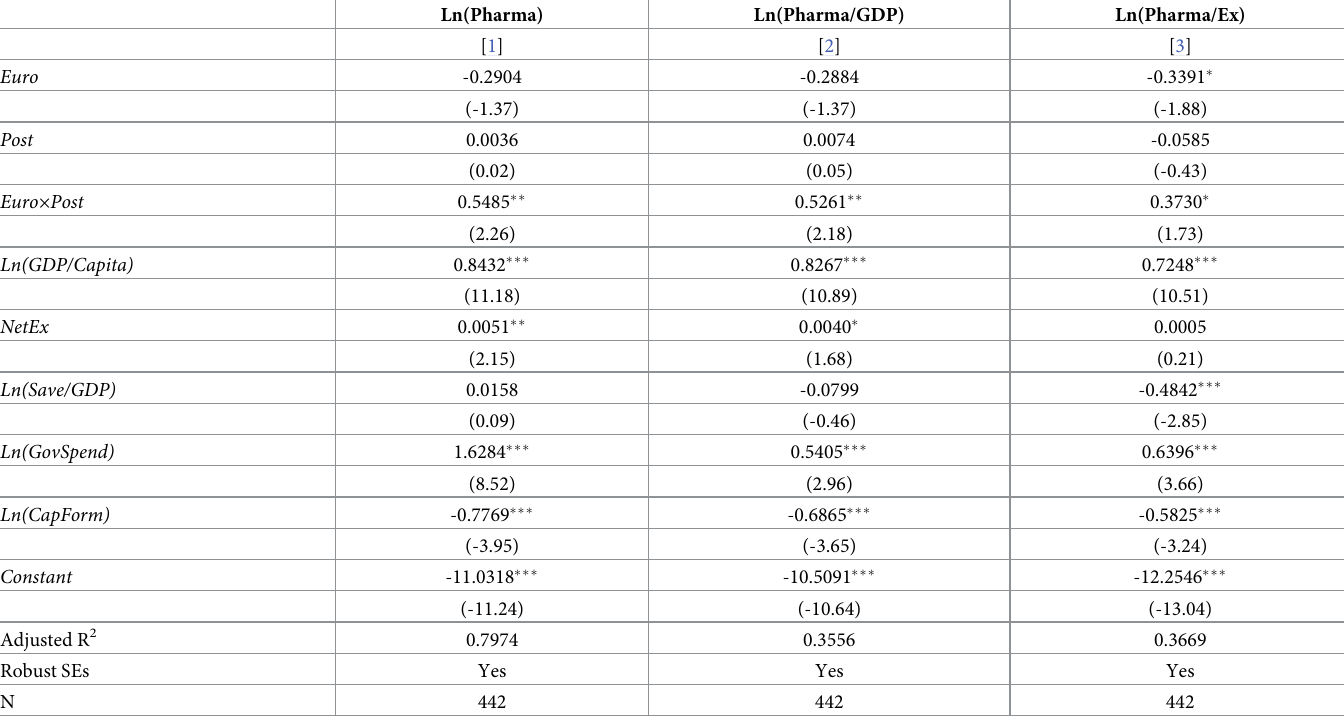
Table 8. Pharmaceutical innovation around the adoption of the